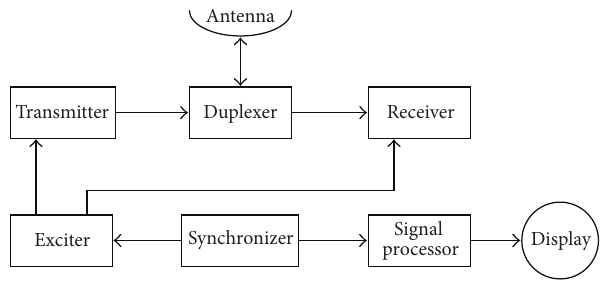
Figure 1: Block diagram of a typical radar